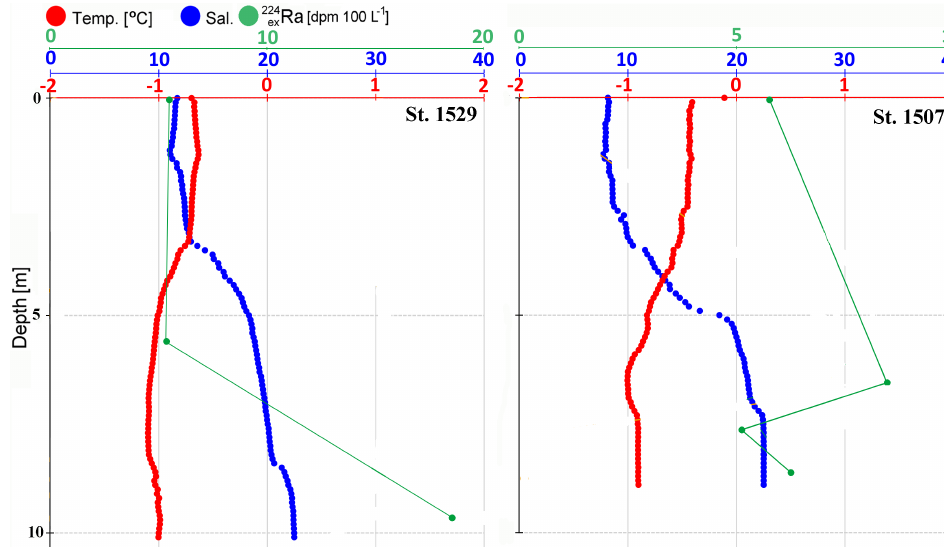
Figure 9. Vertical profiles of the winter water column.